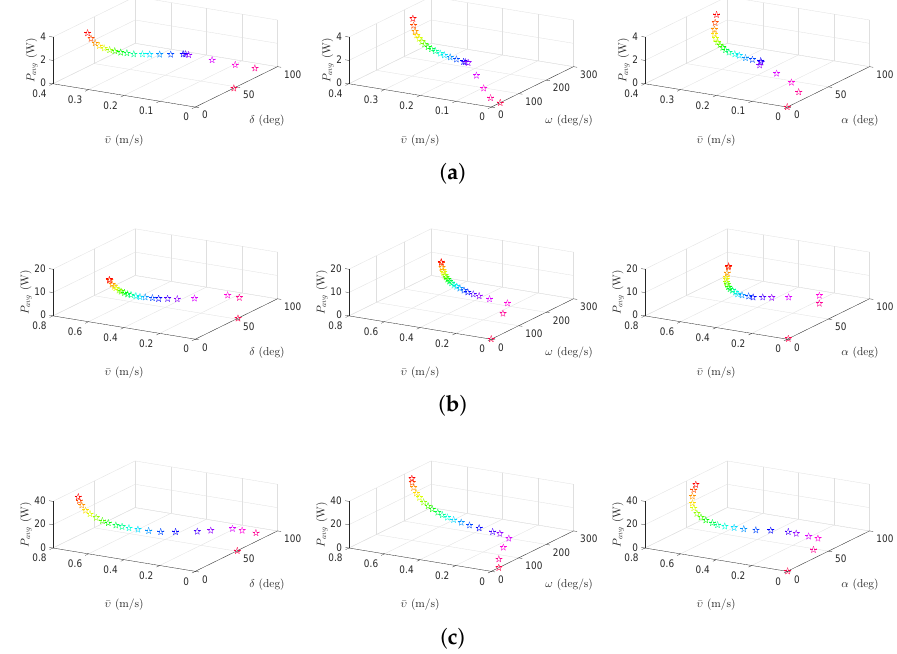
Figure 7. Optimal gait parameters for the eel-like motion pattern for the USR, considering the negative work effect: ( a ) 3D plots of optimal gait parameters for robot with n = 5 links; ( b ) 3D plots of optimal gait parameters for robot with n = 10 links; and ( c ) 3D plots of optimal gait parameters for robot with n = 20 links. Colors illustrate different weights of the objective functions.